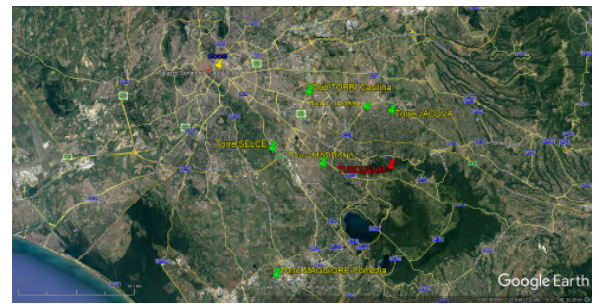
Figure 4. The tenimentum Tusculanum